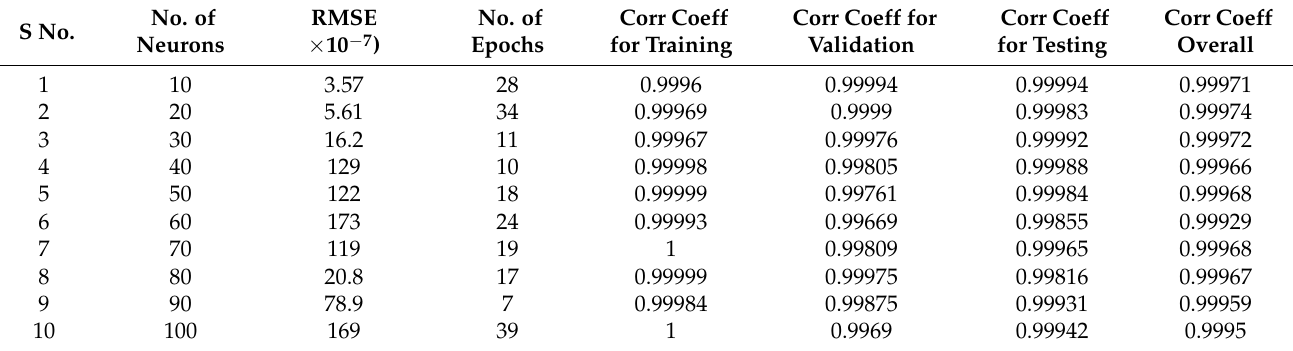
Table 2. Summary of results using varying numbers of neurons in the hidden